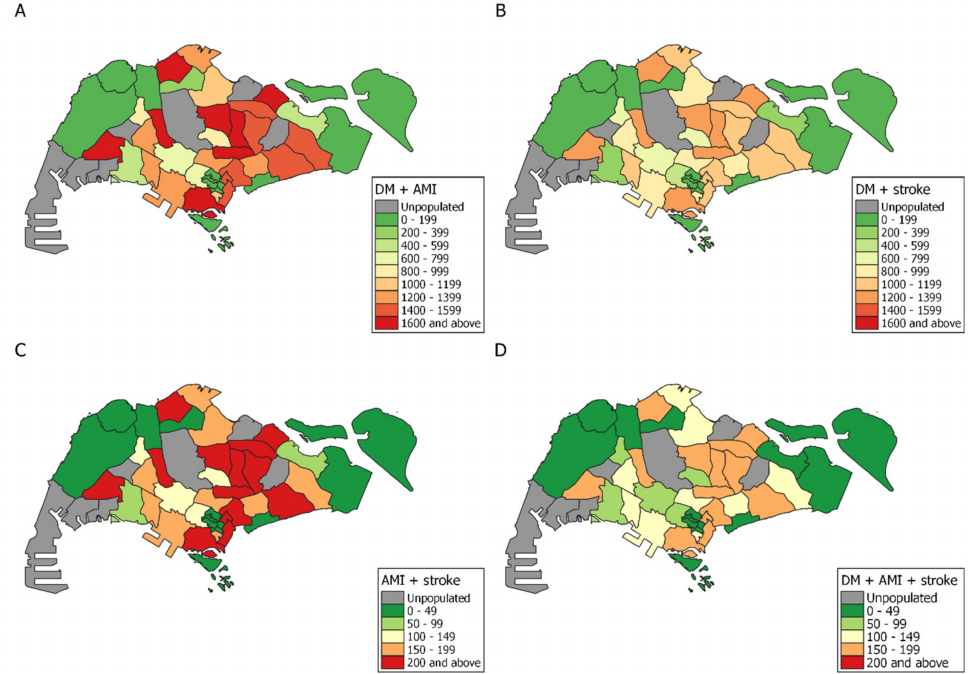
Figure 2. National level maps of comorbidities aggregated by planning area. ( A ) diabetes mellitus (DM) and acute myocardial infarction (AMI), ( B ) DM and stroke, ( C ) AMI and stroke, ( D ) DM, AMI, and stroke. Areas with less than 100 residents were defined as unpopulated and are coloured gray. Simpang and Seletar Island have been omitted as fewer than 10 individuals reside in these locations.